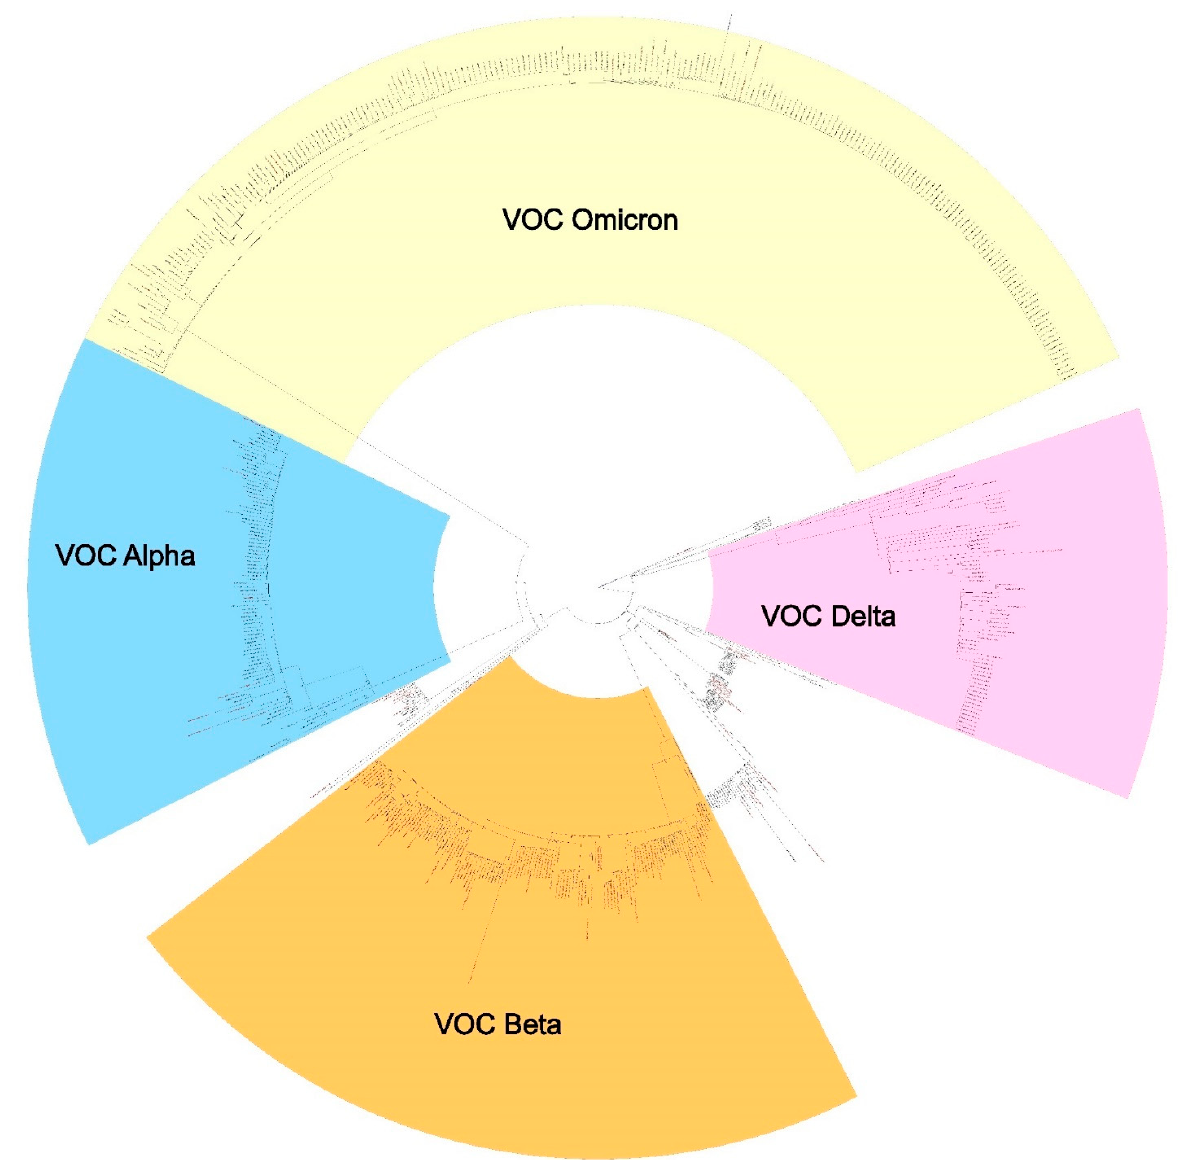
Figure 2. Maximum likelihood tree of all samples > 20,000 nt with their assigned Pango lineages. The Alpha lineage samples are highlighted blue, Beta are yellow-orange, Delta are purple, and Omicron are light yellow. The coding-complete genomes are shown in black, while the non-coding-complete consensus genomes are shown in red. Node labels show bootstraps.